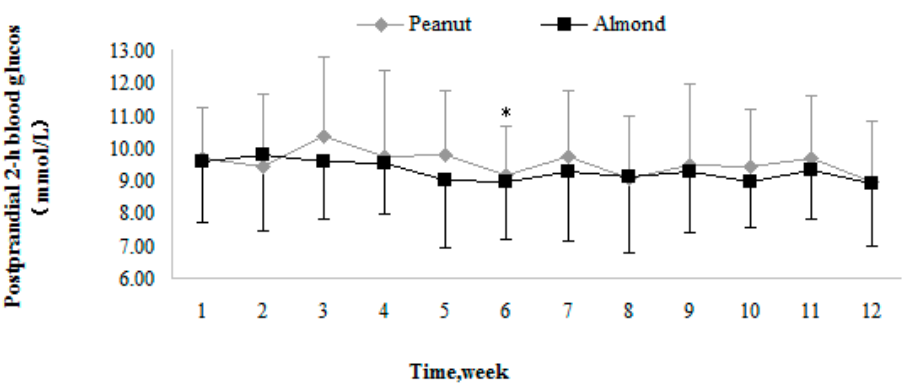
Figure 4. The changing trends of postprandial 2-h blood glucose in the Peanut and Almond groups. Values are means, with their standard deviations represented by vertical bars. For the Peanut group, * PPG was significantly lower at the sixth week than that at the third week ( p = 0.027).